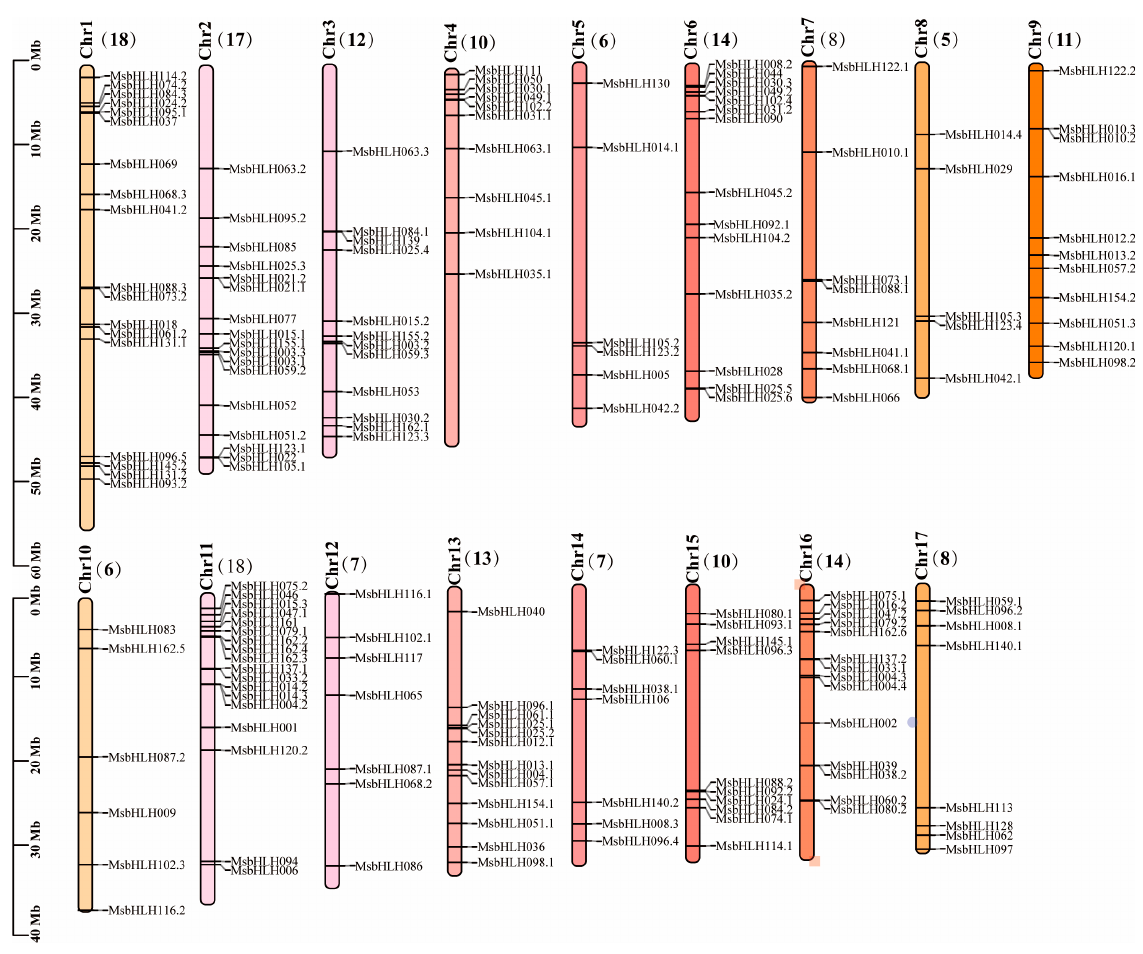
Figure 4. Chromosomal distributions of MsbHLH genes. TBtools was used to analyze maps. The name on the side of each chromosome corresponds to the approximate location of each MsbHLH genes.